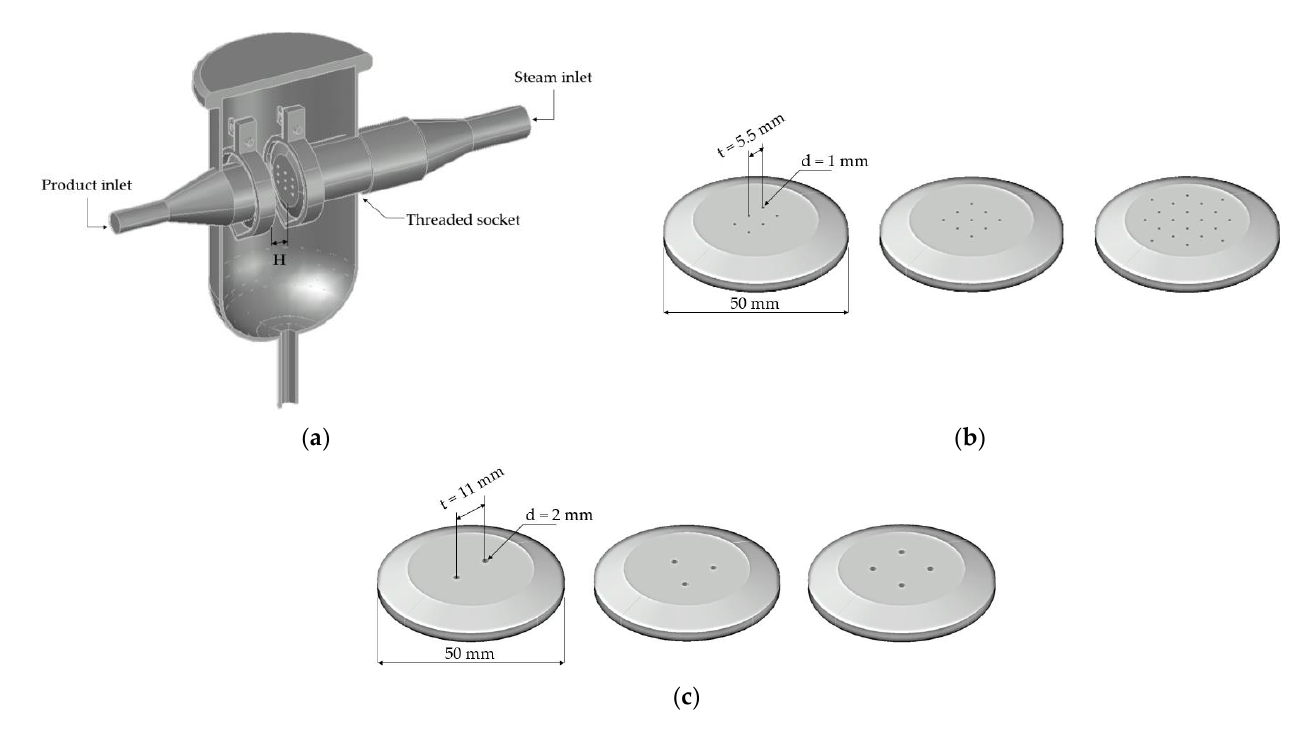
Figure 2. Jet impingement tank ( a ), Steam injection plates; 6, 9, and 20 holes with diameter = 1 mm ( b ), and Product injection plates; 2, 3, and 4 holes with diameter = 2 mm ( c ).